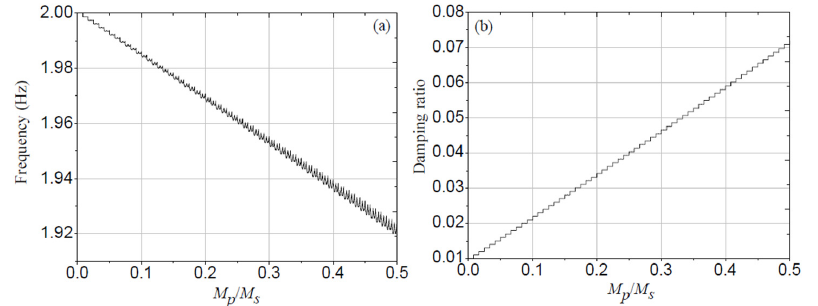
Figure 6. Effect of mass ratio between crowd and structure on dynamic properties: ( a ) the larger mass ratio between crowd and structure induces the lower frequency of structure under resonant excitation; ( b ) the larger mass ratio between crowd and structure results the larger damping of structure under resonant